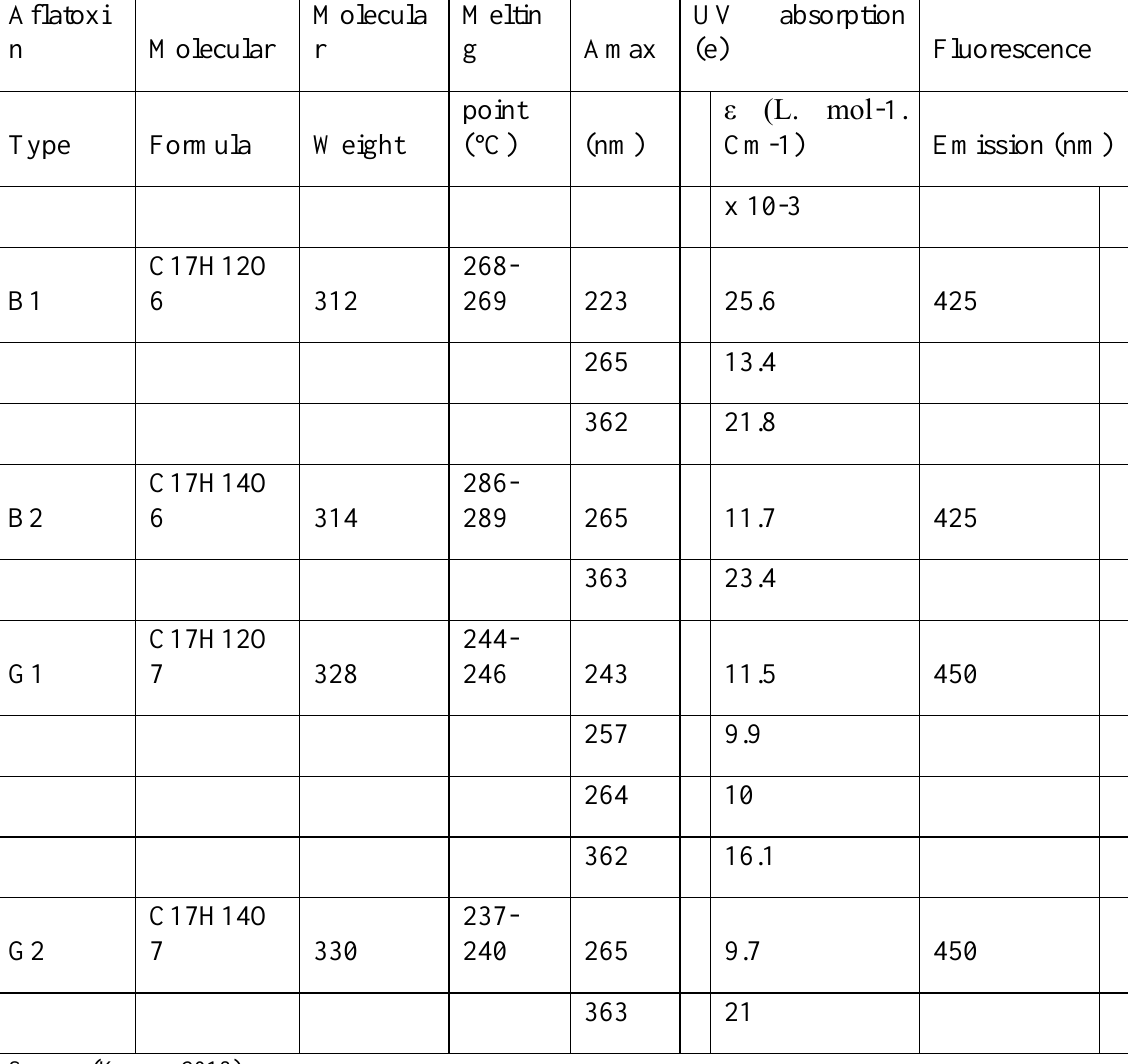
Table 1. Major aflatoxins' physical and chemical